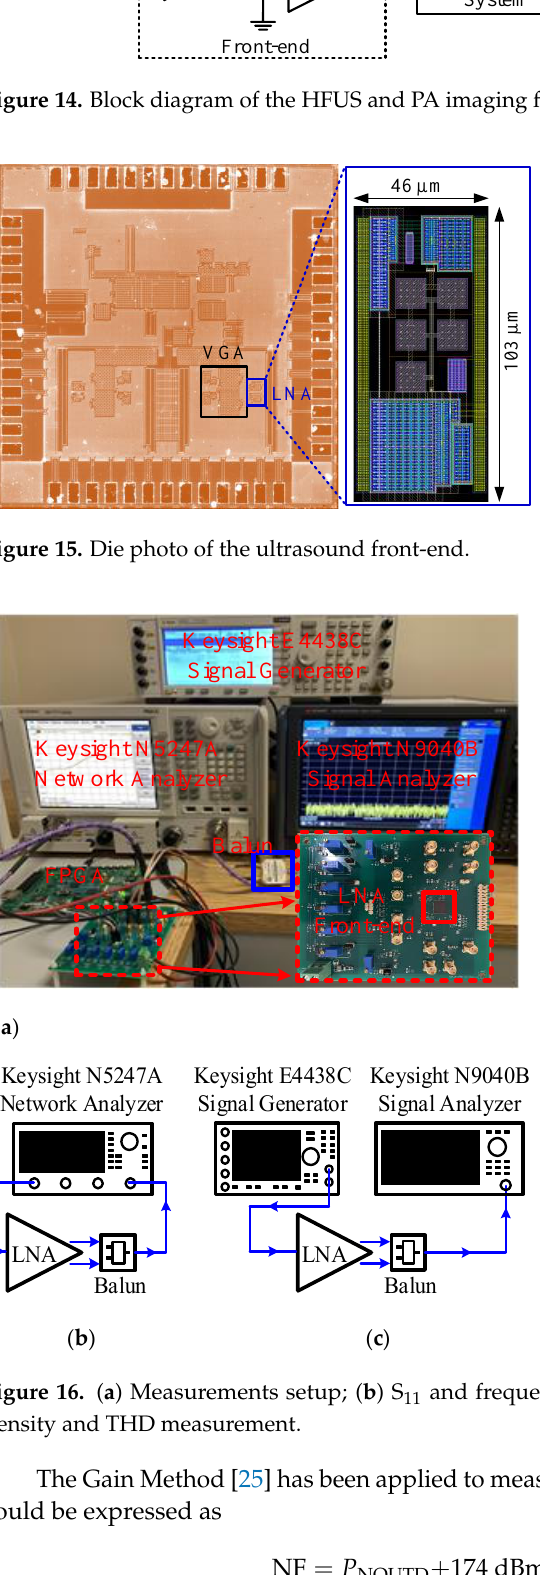
Figure 17. The measured S 11 of the front-end. f -3dB bandwidth line Figure 18. The measured frequency response of the front-end.